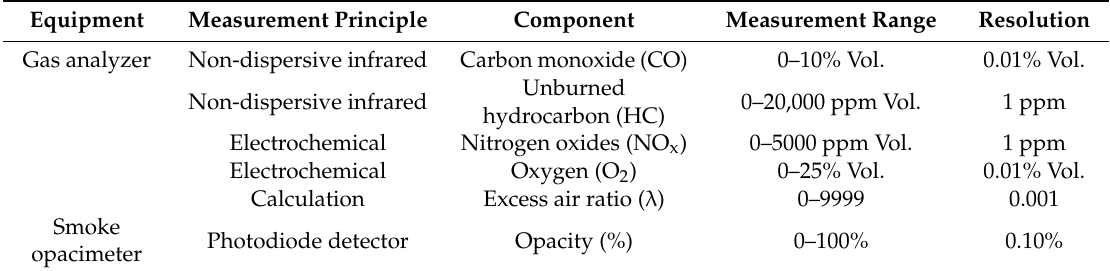
Table 4. Measuring components, ranges and resolution of the AVL DICOM 4000 gas analyzer and DiSmoke 4000 smoke